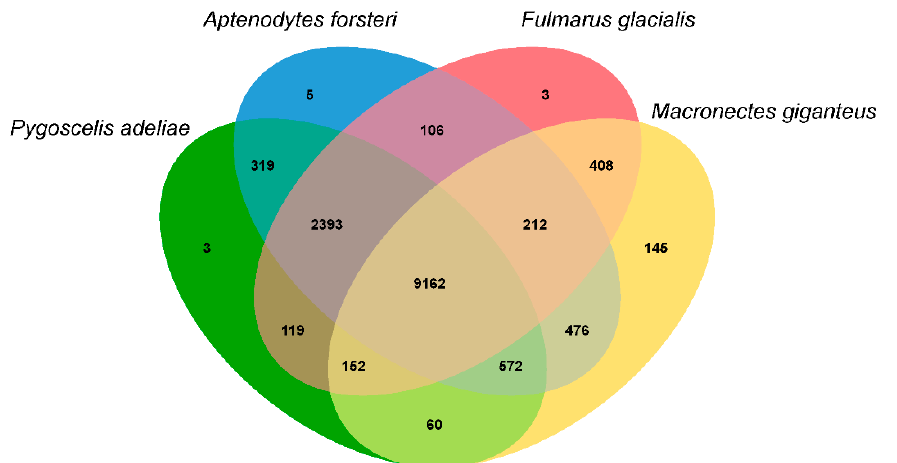
Figure 4. Phylogenetic tree and gene family gain-and-loss analysis, including the number of gained (+) and lost ( − ) gene families. All bootstrap values are 100%, except where denoted.